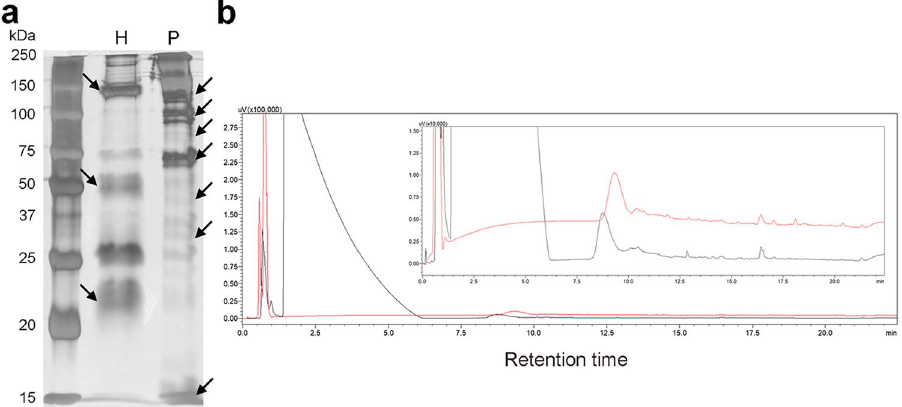
Figure 4. Biochemical characterization of the secretion extracted from the head and posterior region of Siphonops annulatus . ( a ) SDS-PAGE of the secretion of the head (H) and of the posterior region (P) (See Fig. 4S for the original image). The numbers on the left refer to the molecular mass markers (kDa) shown in the left column. Main differences between the two types of secretion are indicated by arrows. ( b ) C18-RP-HPLC profiles of secretions extracted from the head (red) and from the posterior region (black). The insert represents a high magnification of the